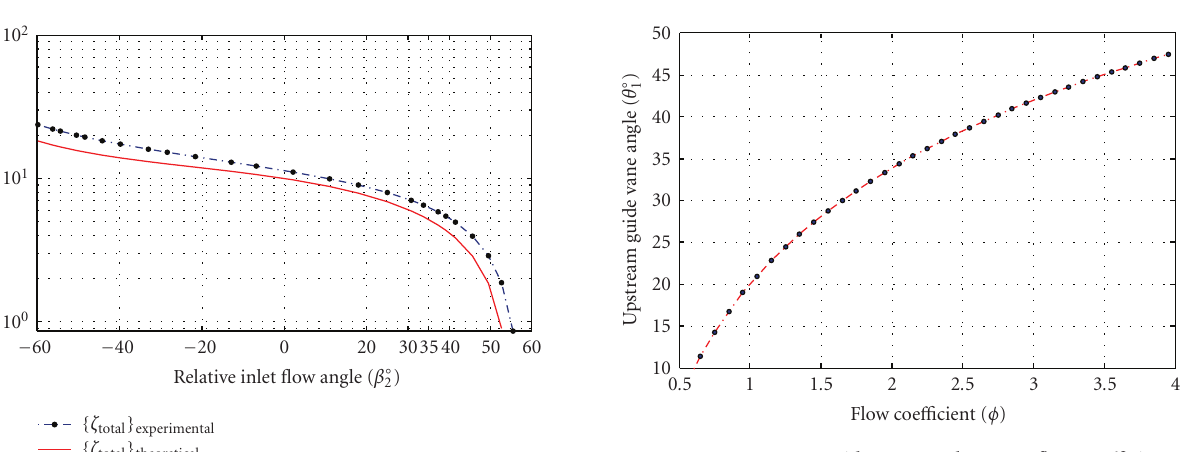
Figure 13: Upstream guide vane angle versus flow coe ffi cient.